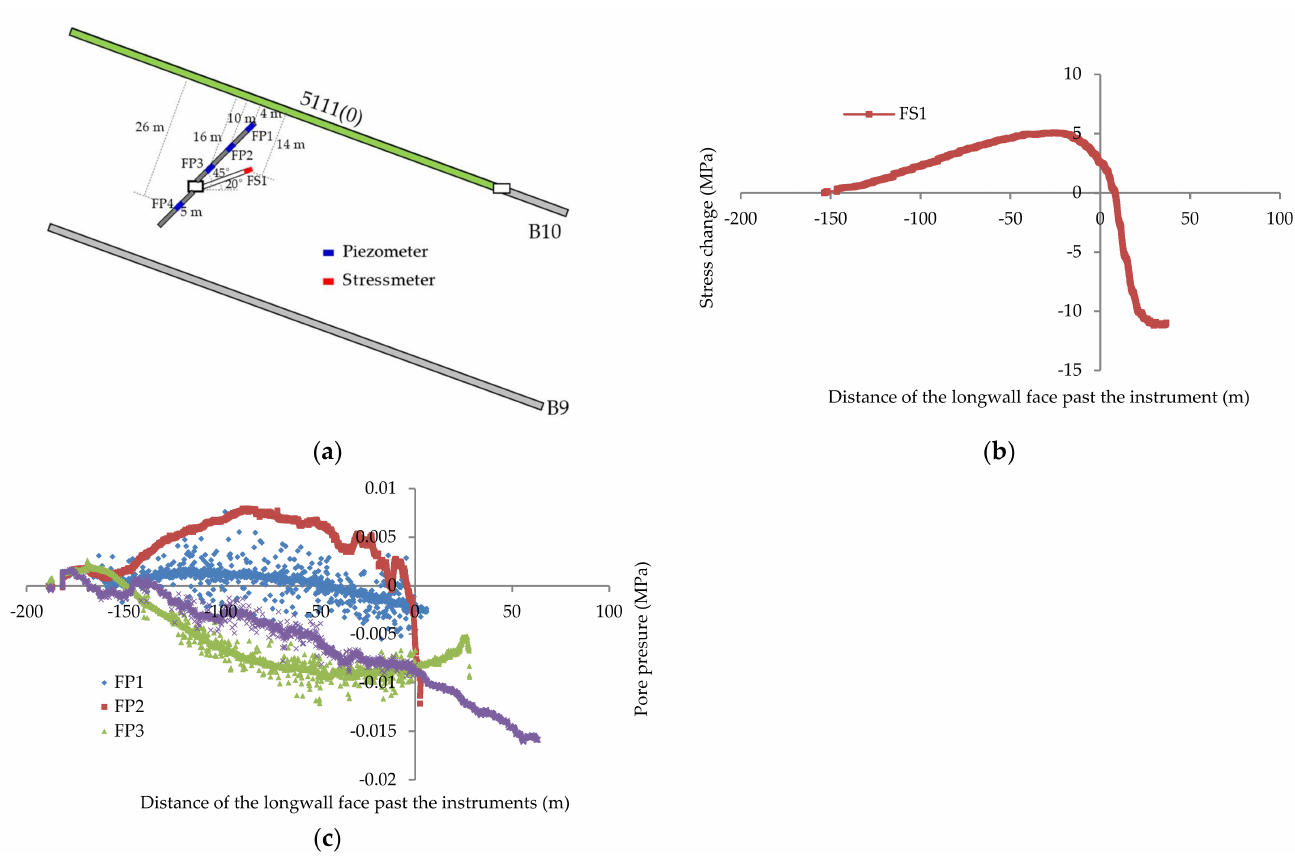
Figure 6. The key results from the rock roadway underneath the LW 5111(0) panel: ( a ) location of the instruments; ( b ) stress change monitored by the stressmeter FS-1; ( c ) monitored pore pressure